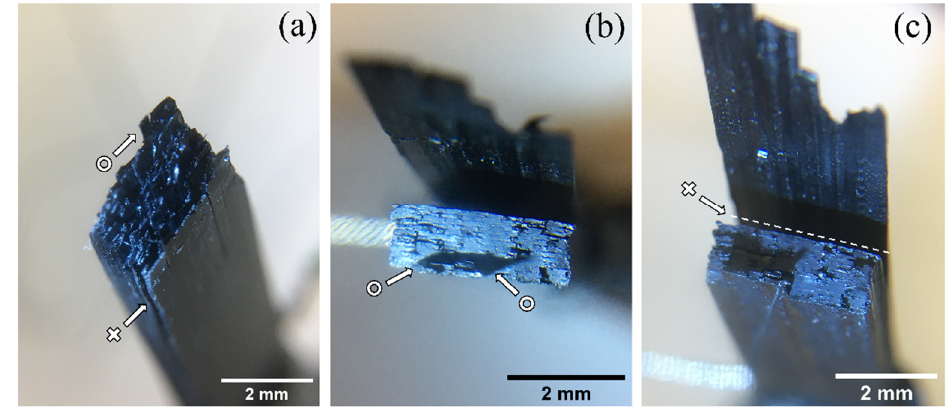
Figure 6. Optical microscopy on fracture surfaces of two different PEEK 3CNT 3D-printed samples (( a ) sample 1, and ( b , c ) sample 2) showing line–line delamination (circle) and layer–layer delamination (cross).